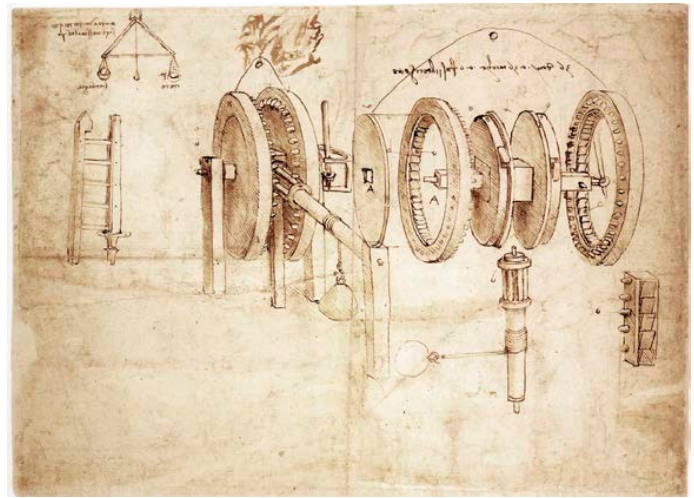
Figure 4. Leonardo da Vinci, Codex Atlanticus,